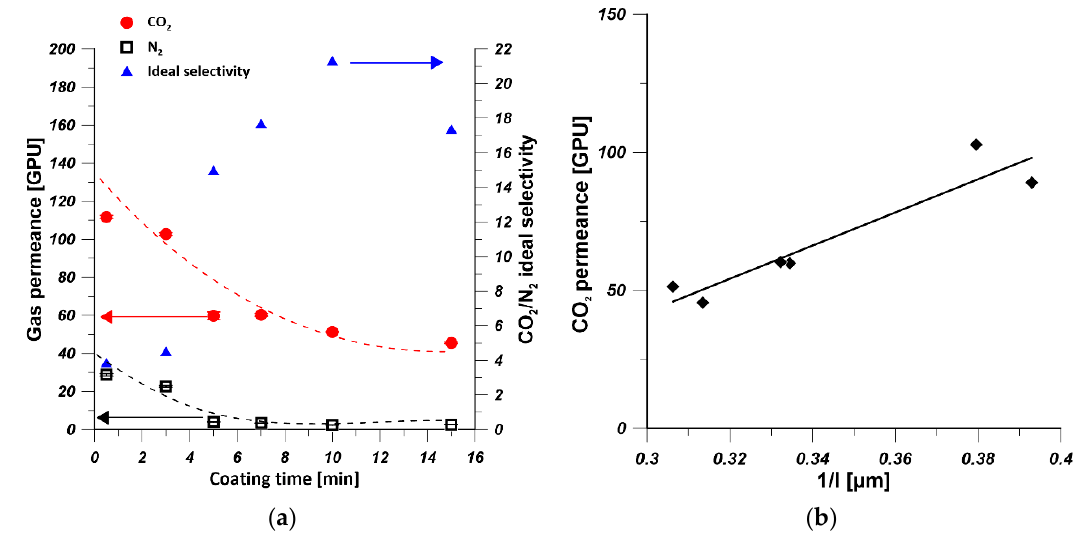
Figure 5. ( a ) The effect of coating time on gas permeance and ideal selectivity of PDMS/PEI membranes prepared from 15 wt% of PDMS solution (the dashed line indicates only the trend of gas permeance change). ( b ) The influence of PDMS layer thickness (l) on CO 2 permeance of PDMS/PEI membranes prepared from various 15 wt% of PDMS solution at various coating time (the average thickness of PDMS layer was calculated based on the thicknesses of PDMS layer at the top and bottom parts).